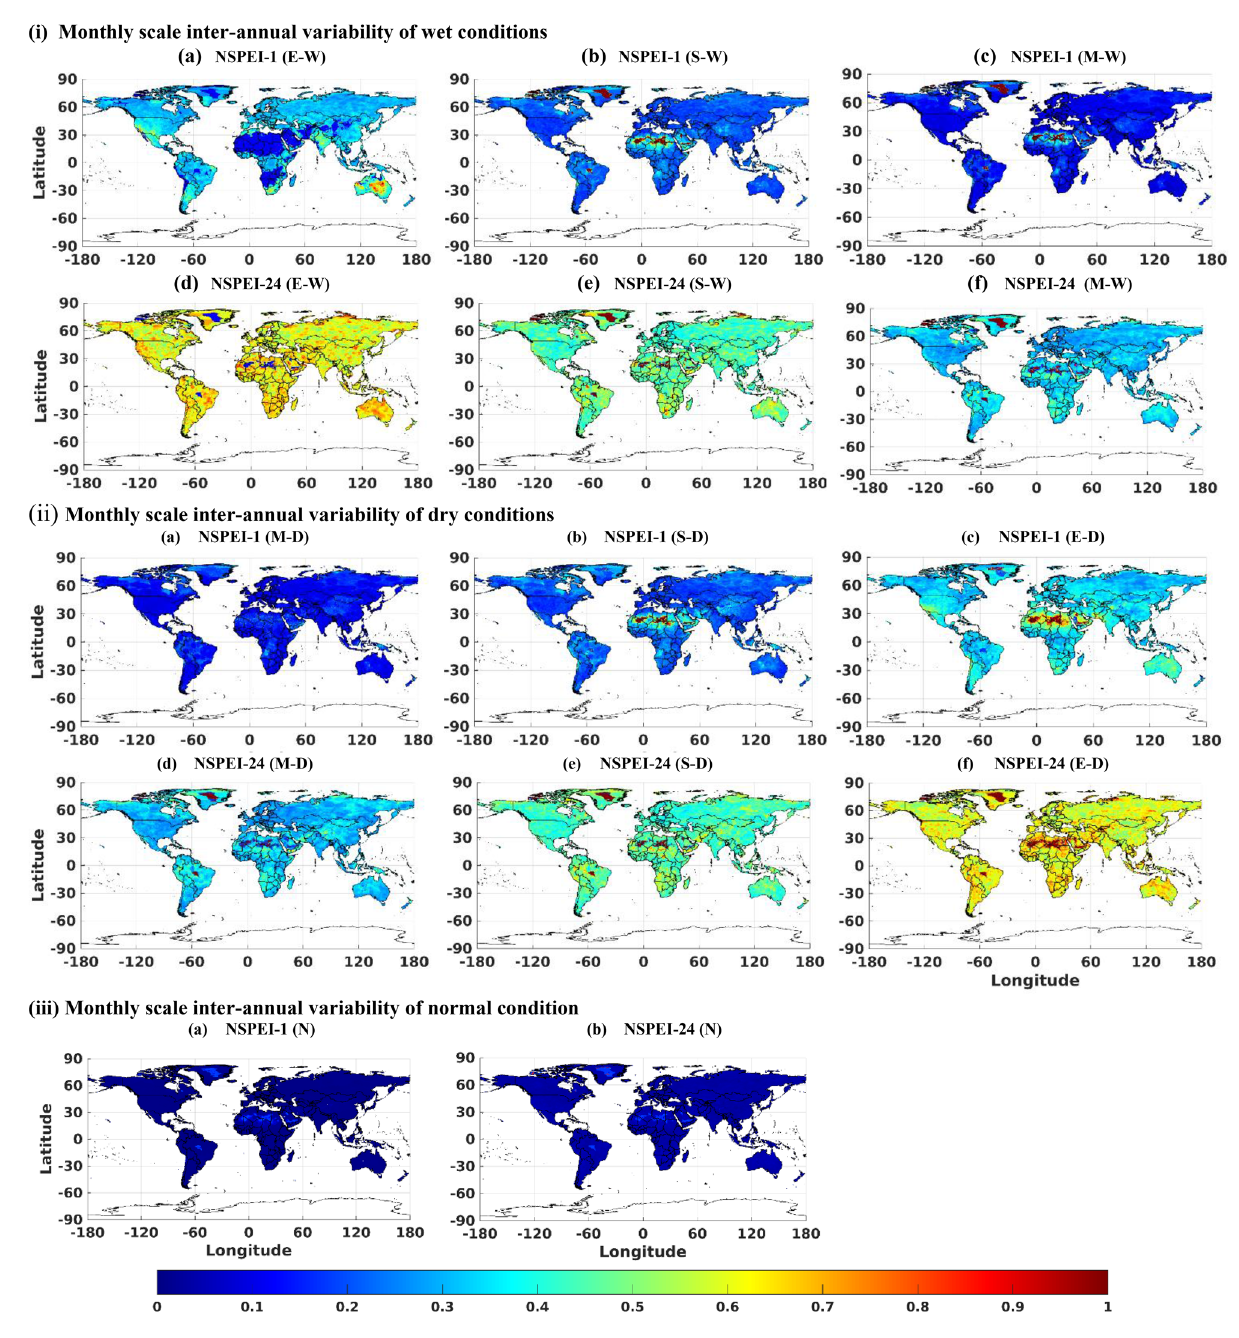
Figure 1. Monthly scale inter-annual variability (SVI ME ) of (i) wet (W), (ii) dry (D), and (iii) normal (N) conditions for the period 1901 to 2019. In the notation NSPEI- M , M indicates the accumulation period (AP) in months. Extreme, severe and moderate-intensity levels of wet conditions are denoted by E-W, S-W, M-W, respectively. The corresponding intensity levels in the case of dry conditions are denoted by E-D, S-D, M-D, respectively. *The maps were generated using MATLAB (version: R2021a; https:// www. mathw orks. com/ produ cts/ matlab. html